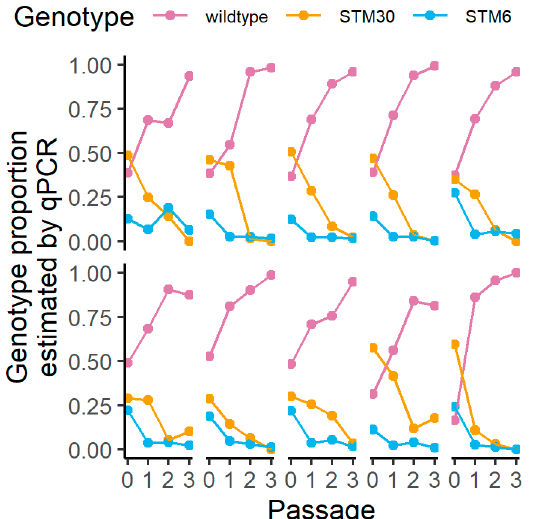
Figure 4. Change in proportion of three genotypes over serial exposure to in planta growth in magenta boxes. Ten independent lineages with initial inoculations containing wild type, STM30, and STM6 genotypes were passaged and global changes in the proportion of each genotype were modeled over passage time. The proportion of the more beneficial genotype was estimated using qPCR at four different time points: the initial inoculation and after passages 1, 2, and 3 of in planta growth. The order of benefit provided by rhizobial symbionts is wild type > STM30 > STM6. Pink = wild type, orange = STM30, and blue = STM6.